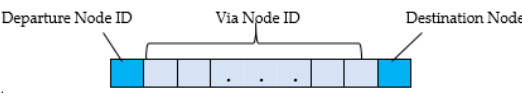
Figure 2. Individual route planning method.